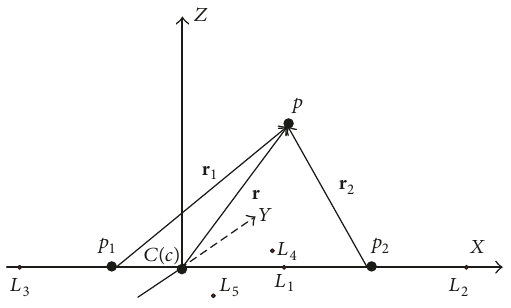
Figure 1: The barycenter synodic coordinates 𝐶 - 𝑋𝑌𝑍 and the libration